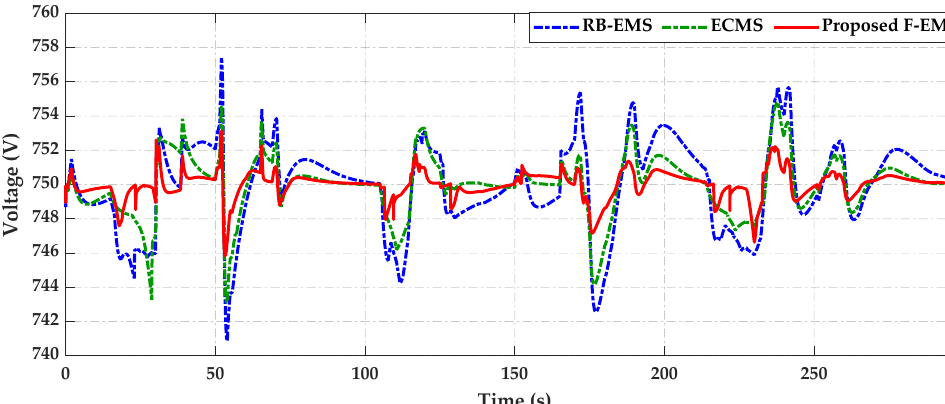
Figure 11. The comparison of the DC bus voltage.